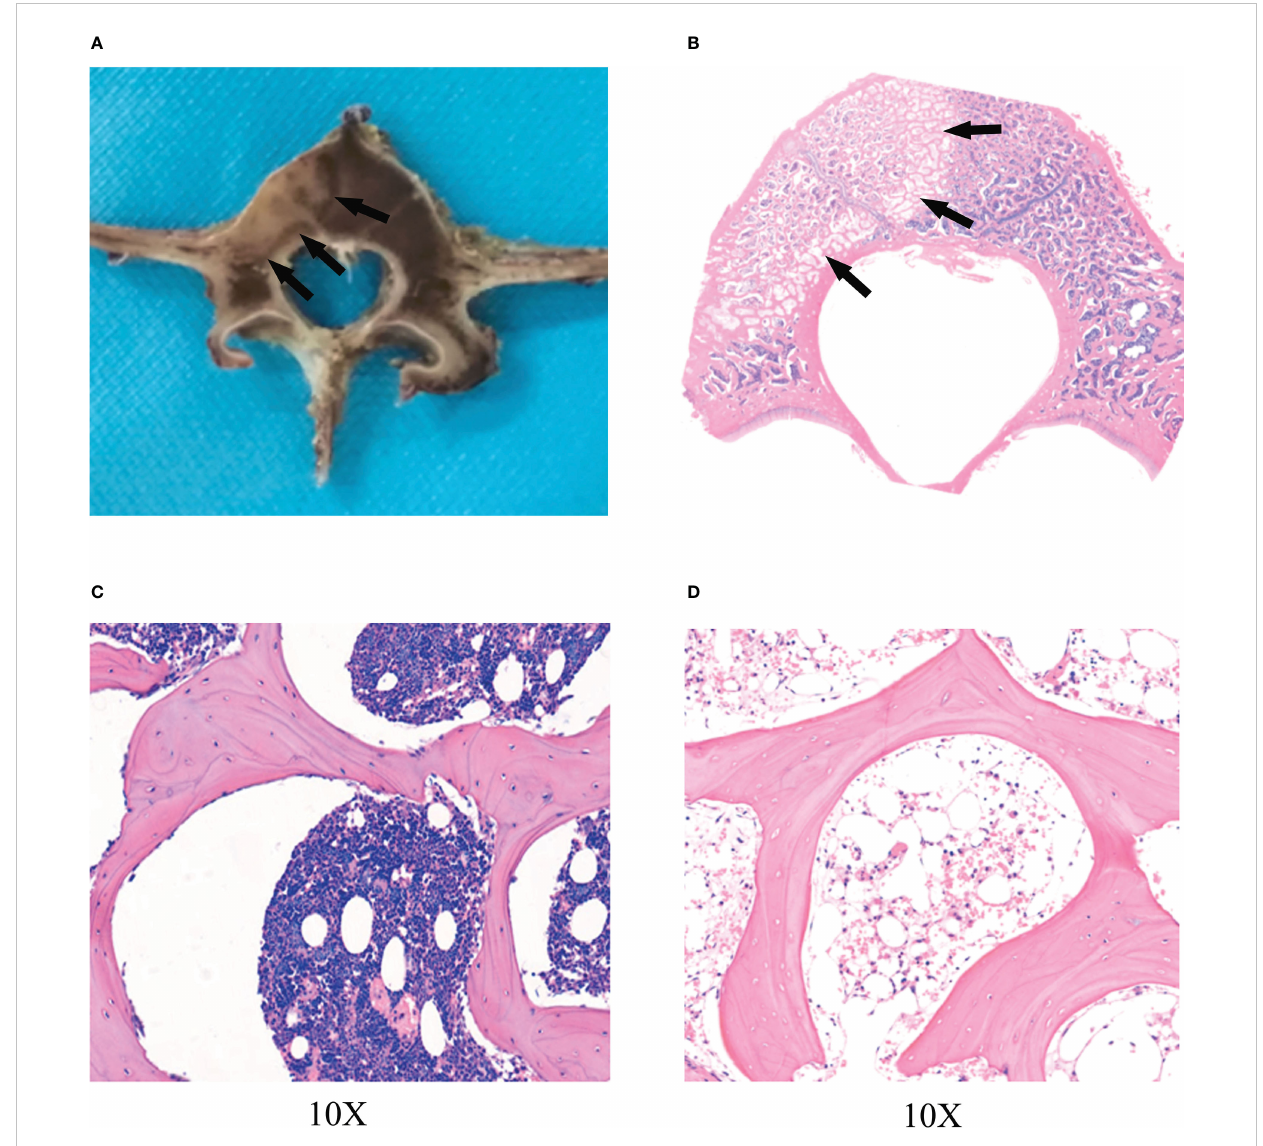
FIGURE 1 The zone of RFA. (A) Radiofrequency ablation (RFA) lesion in vertebra by transverse plane. The zone of RFA in the vertebra showed gray-white changes, with thin layers of gray-black rim (black arrows) around the center on day 14. (B) Hematoxylin and eosin (HE) showed a clear radiofrequency ablation zone (black arrows) on day 14. A circular bone marrow deletion zone can be seen around radiofrequency ablation lesion. The trabeculae remained intact, but the number of bone marrow cells in the trabeculae and the number of osteoblasts covering the trabeculae were signi fi cantly reduced, especially in the surrounding zones (black arrows) of radiofrequency ablation. (C) The zone of radiofrequency ablation was observed at 10X. (D) Normal